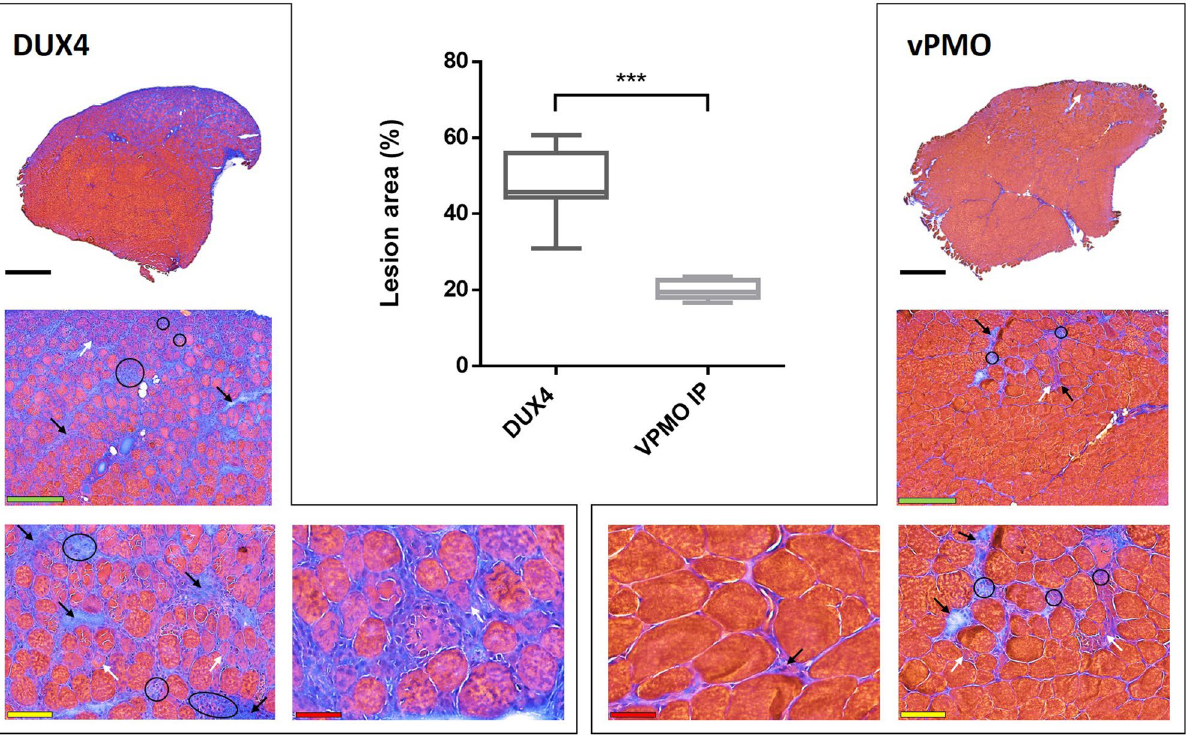
Figure 9. vPMO treatment of mice electroporated with DUX4-expression plasmid decreases TA muscle lesions. TA muscles were injected by hIMEP with 20 µg of pCineo-DUX4 plasmid. Six hours later, mice received either an intraperitoneal injection of 250 µg of vPMO pLAM3A (− 12 + 13) targeting DUX4 mRNA (vPMO group) or no supplemental treatment (DUX4 group). Percentage of lesion area was evaluated 7 days post IMEP by color thresholding using ImageJ on HEB colored cryosections of TA proximal and medial parts. Results are presented as Box plots, ***p < 0,001 by Mann–Whitney Rank Sum Test; n = 4 for each group. The graph was generated using GraphPad Prism 6.01. Black arrows show fibrosis, white arrows atrophic fibres, black circles inflammatory infiltrate. Scales 1 mm (black) 250 µm (green), 100 µm (yellow) and 50 µm